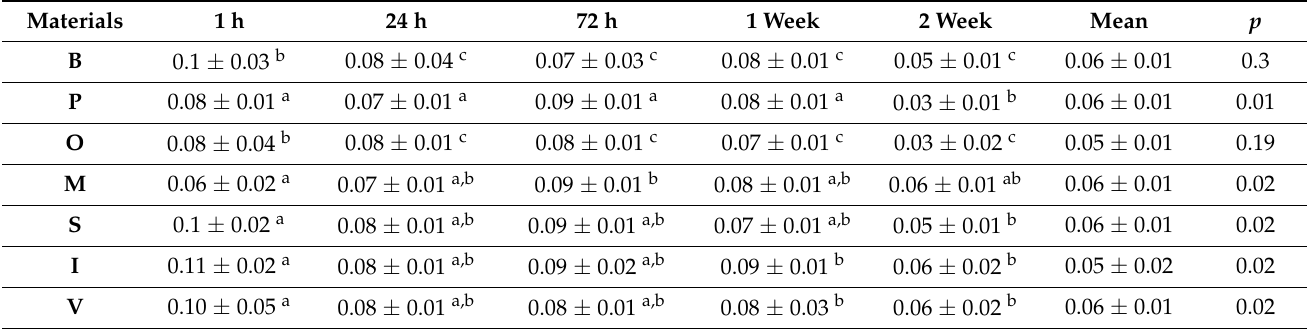
Table 3. Cont. Table 3. The mean and standard deviations of absorbant index level per material in artificial saliva (AS). Different letters a,b,c in the same column indicate significant differences ( p < 0.05). See Table 1 for group abbreviations.